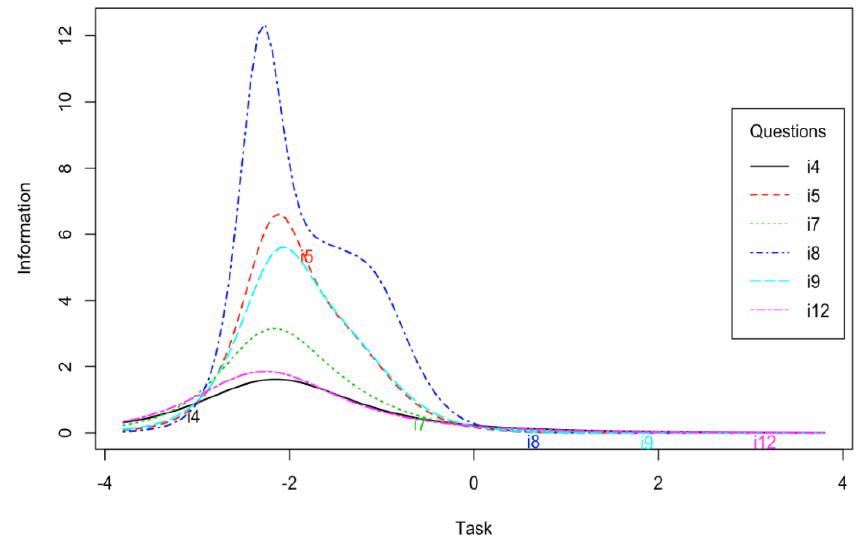
Figure 3. Information curves for the POSQ task subscale items. Int. J. Environ. Res. Public Health 2020 , 17 , x FOR PEER REVIEW